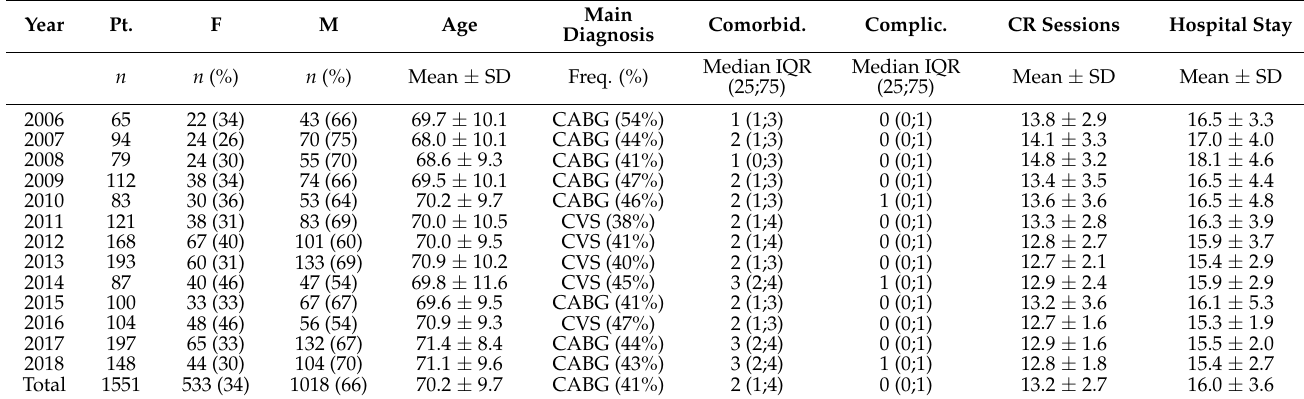
Table 1. The characteristics of the study cohort by